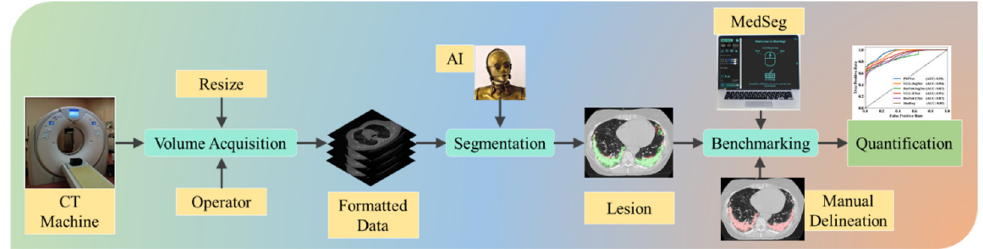
Figure 1. AI system workflow for comparing COVLIAS 1.0 Lesion against MedSeg.